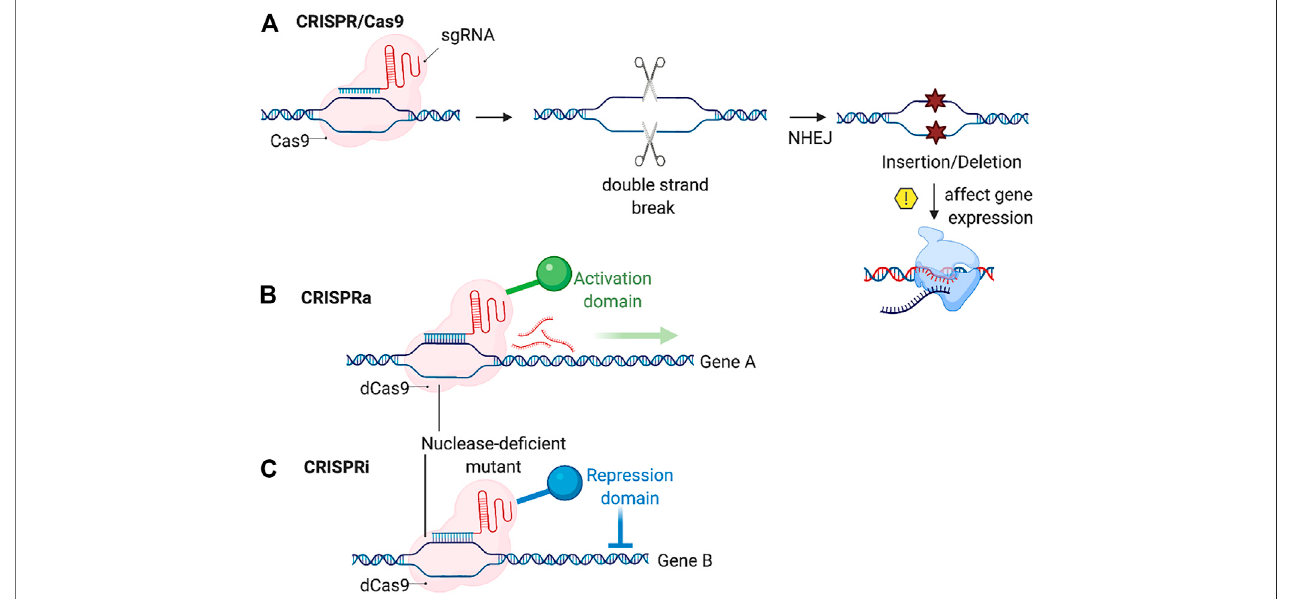
FIGURE4| SchematicshowingCRIPSRbasedgenomeediting. (A) CRISPR/Cas9systemworksbythesgRNArecognizethetargetDNAthentheCas9preforma doublestrandbreak,theNHEJrepairsystemthenmaycausesinsertionordeletionresultinginachangeinthetargetgeneexpression. (B,C) CRISPRa/CRISPRisystems worksby the sgRNA recognition ofthe target site followed by the activation or repression of gene expression ofthe target gene via an activation or arepression domain, altering the gene expression of the target gene (Created with BioRender.com).